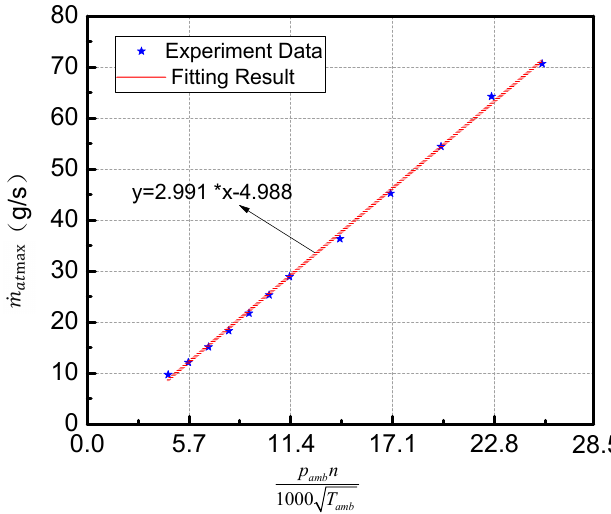
Figure 4. max at m fitting results relative to engine speed and ambient temperature.